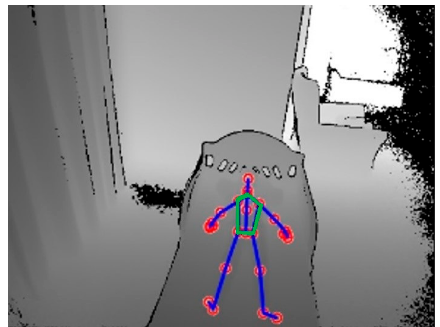
Figure 3. Skeletal joints of the child (5 years) provided from the Kinect code library and the selected region of interest (ROI; the green pentagon defined by the 5 joints).